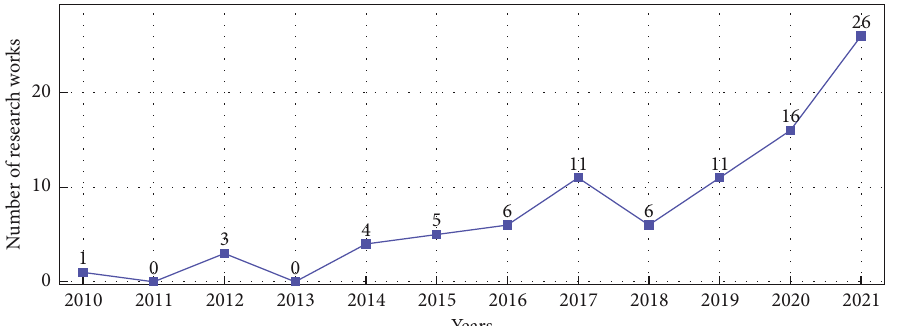
Figure 1: Illustration of the number of publications in Scopus and Web of Science per year. +e resulting publications are based on research papers that address GVRPs considering emissions using heuristics and hybrid